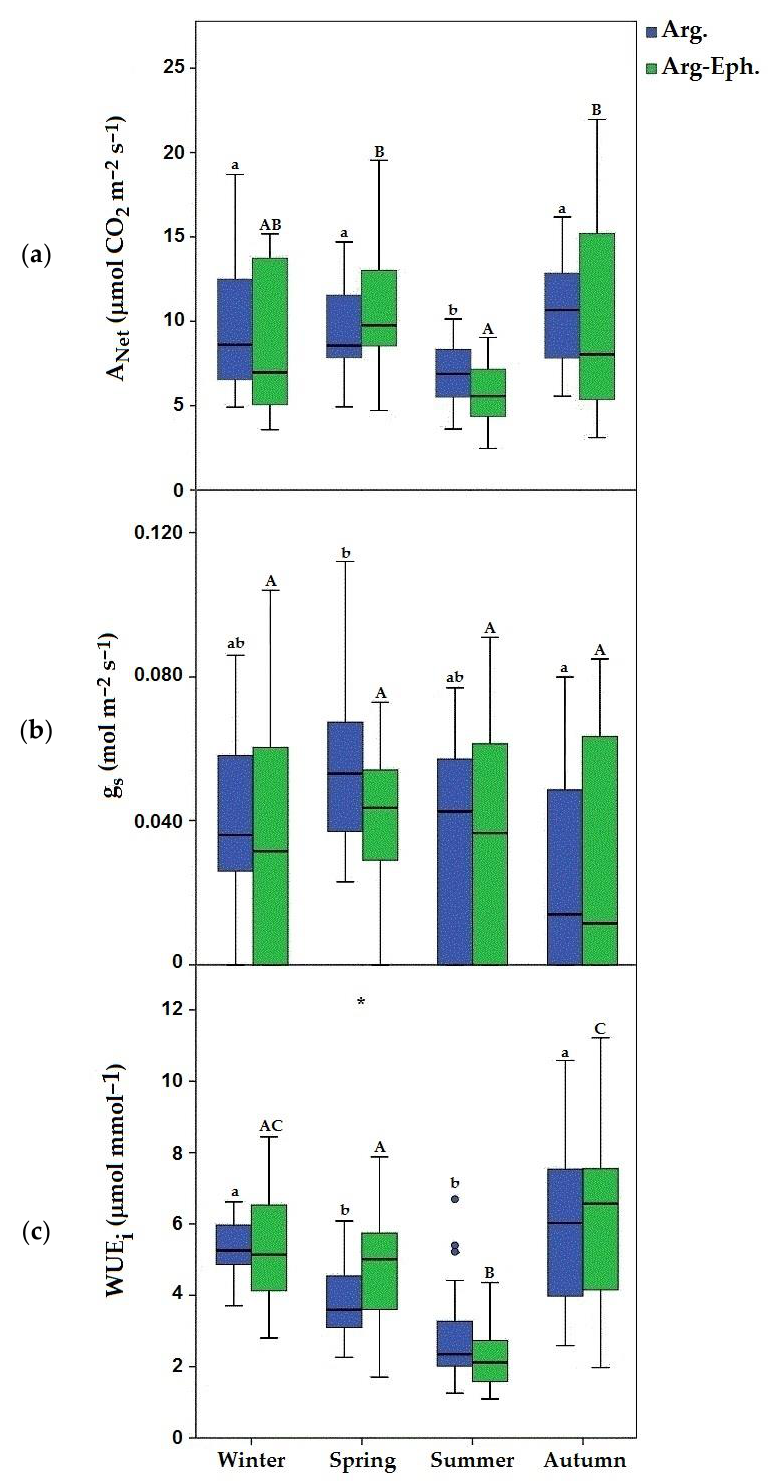
Figure 3. Box plots of the Net photosynthetic rate, A Net ( a ), stomatal conductance, g s ( b ) and instantaneous water use efficiency, WUE i ( c ), of the Argan trees with (Arg-Eph.) and without the liana (Arg.) throughout the study period. The asterisks show significance levels when comparing the two sites within each season by students’ t -tests (* p < 0.05). Lower-case and upper-case indicate Post-hoc test